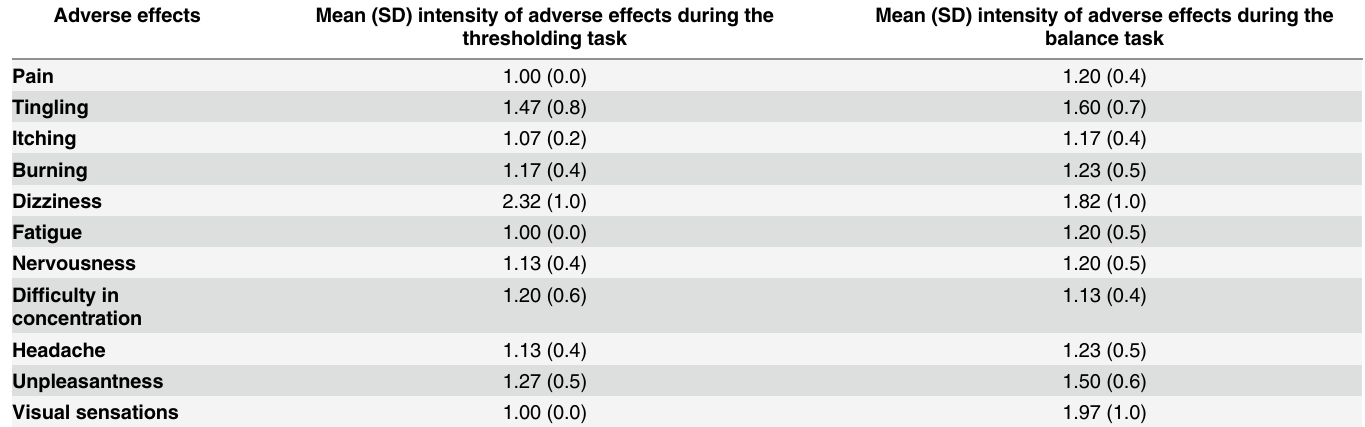
Table 4. Mean (SD) of subjective assessment scores after thresholding and balance tasks (n =